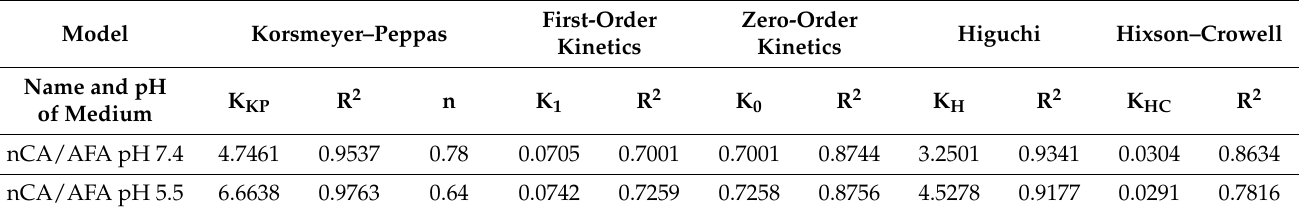
Table 4. The kinetic parameters of AFA released from the nCA/AFA nanocomposite using different pharmacokinetics